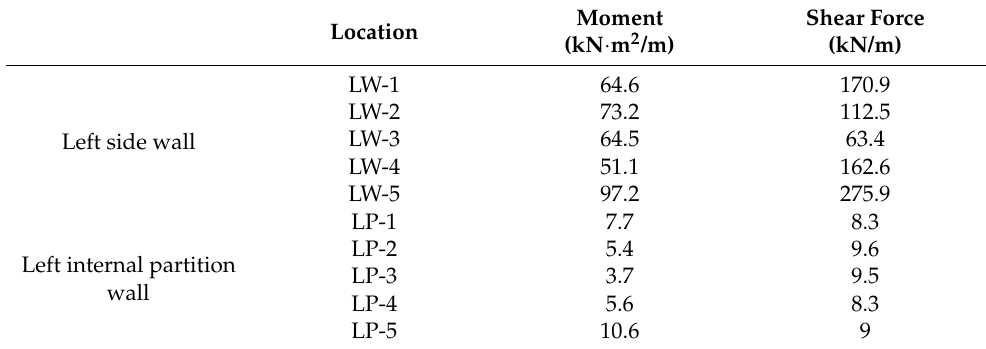
Figure 9. Time histories of bending moment and shear force at the bottom of the left wall in the 2 m burial depth model. Table 2. Distribution of bending moments and shear forces of structural members in the 2 m burial depth model.